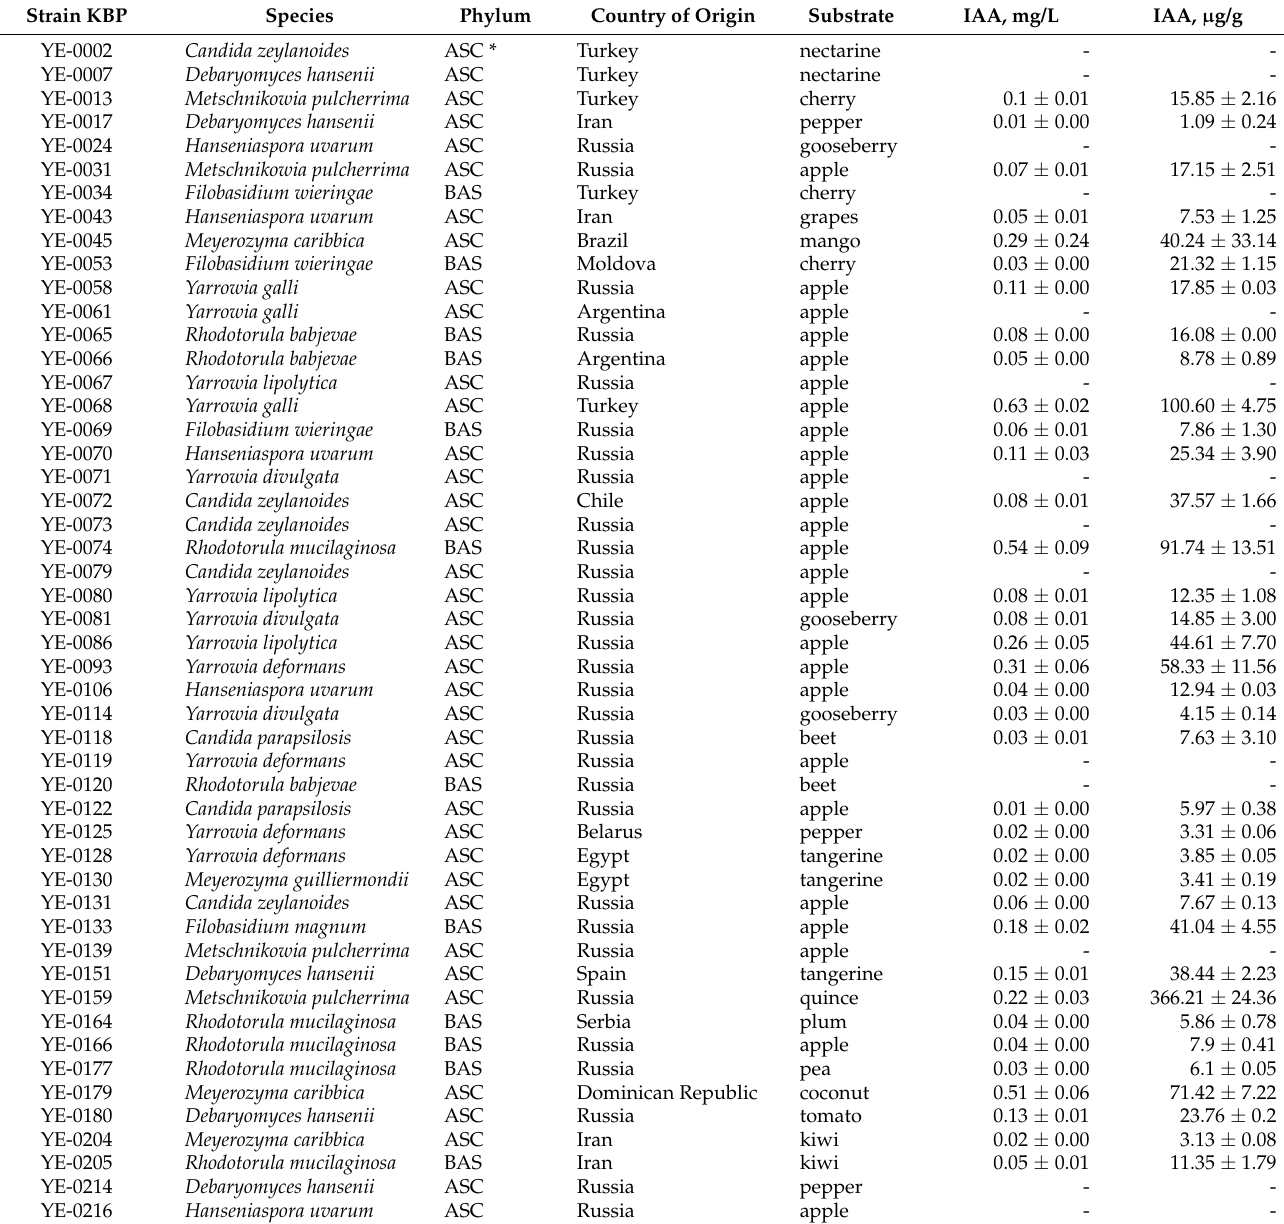
Table 1. IAA production (with standard deviations) of studied strains and information about